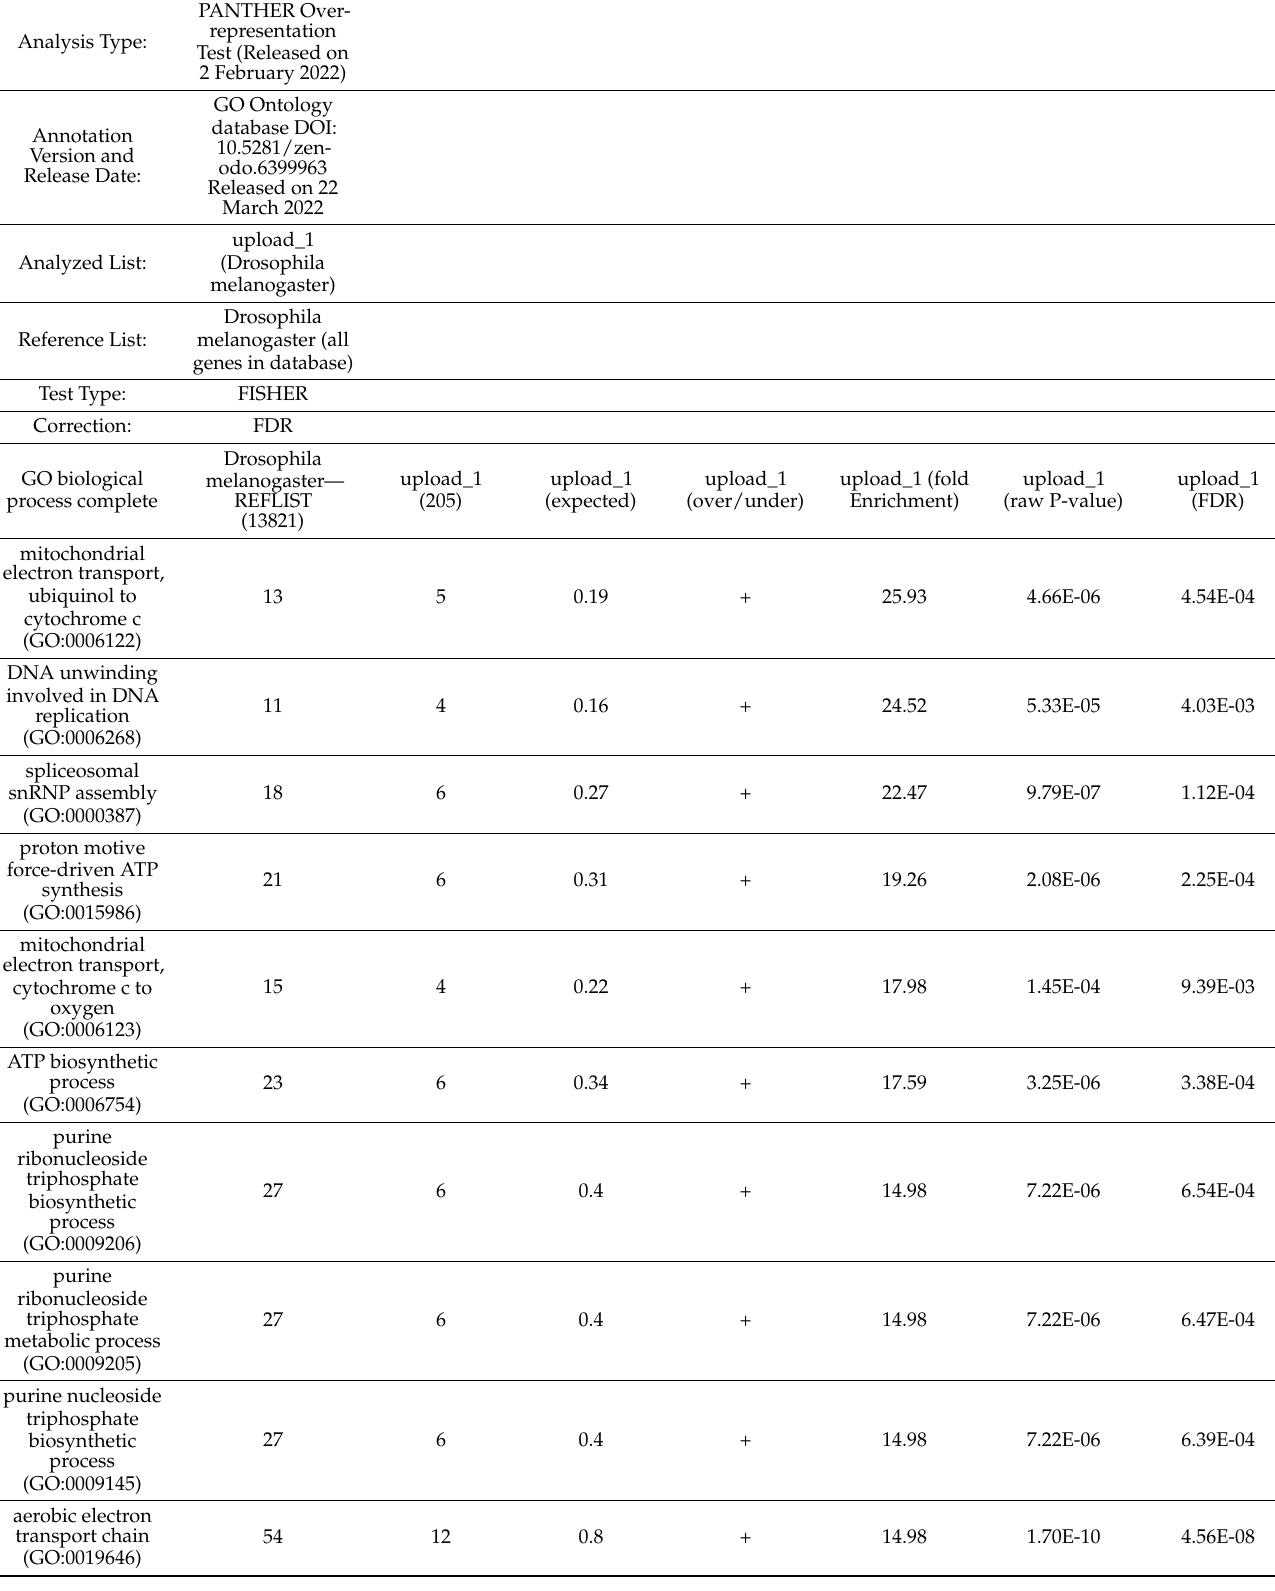
Table A3. Gene ontology analysis of the fate undetermined DEGs indicated enrichment in metabolic processes, DNA replication, RNA splicing and translation initiation suggestive of highly active, premature, growing